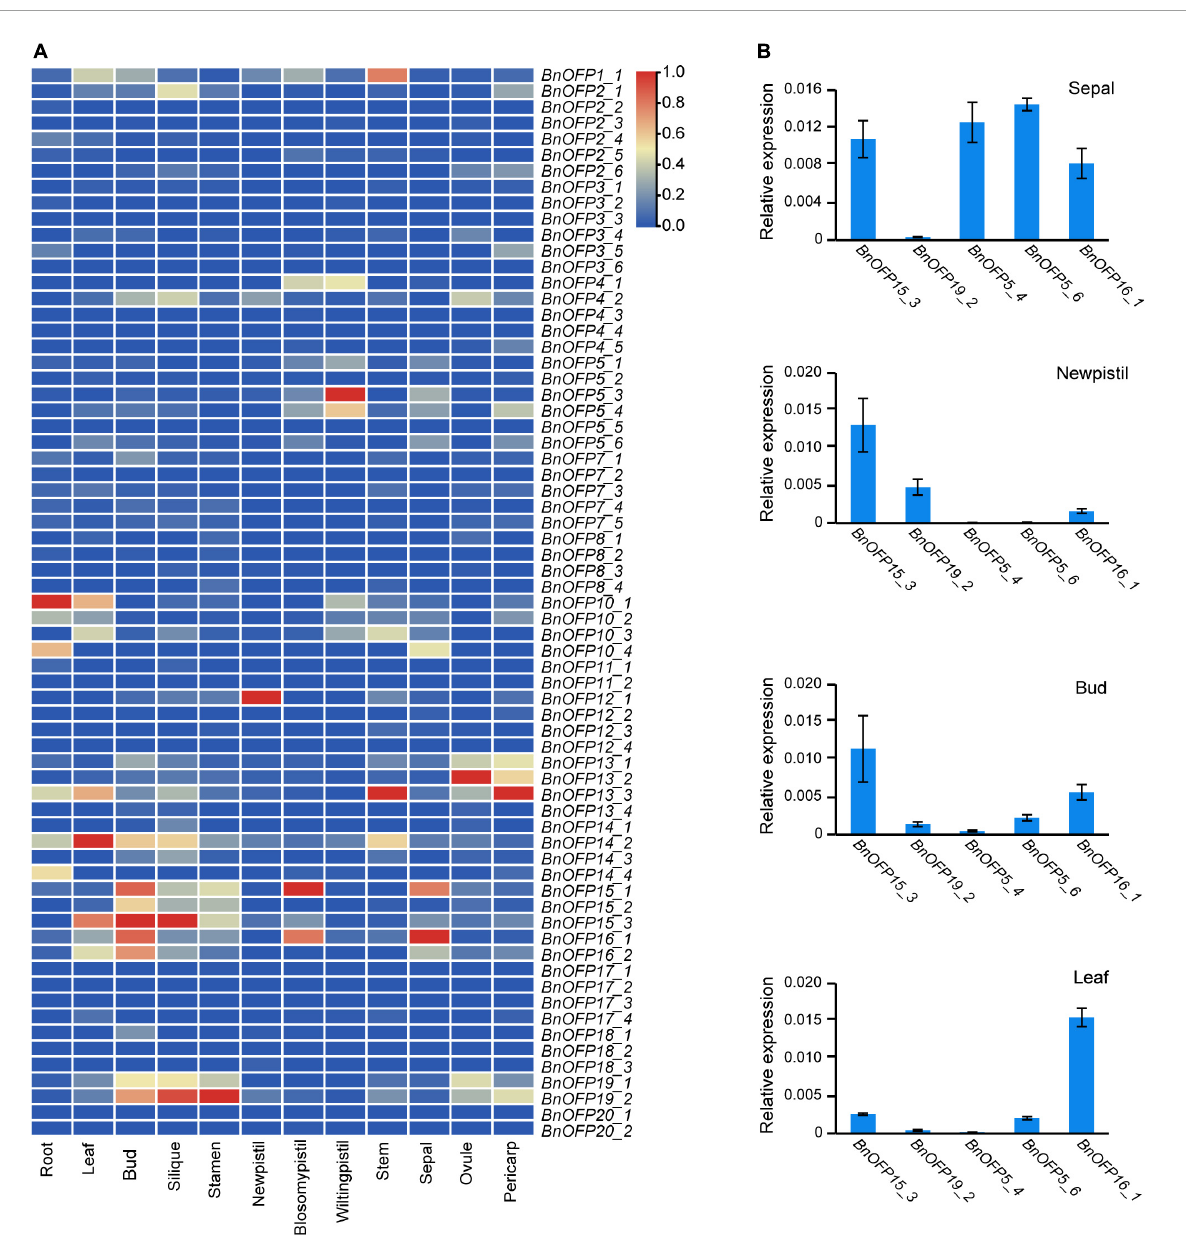
FIGURE5 Expression patterns of BnOFP genes. (A) Heatmap of gene expression patterns. Expression levels of 67 BnOFP genes in twelve tissues of ‘ZS11’ obtained from FPKM of transcriptome analysis. (B) Verification of the expression level by qRT-PCR. Five genes and four tissues were used to verify the expression level in transcriptome analysis by